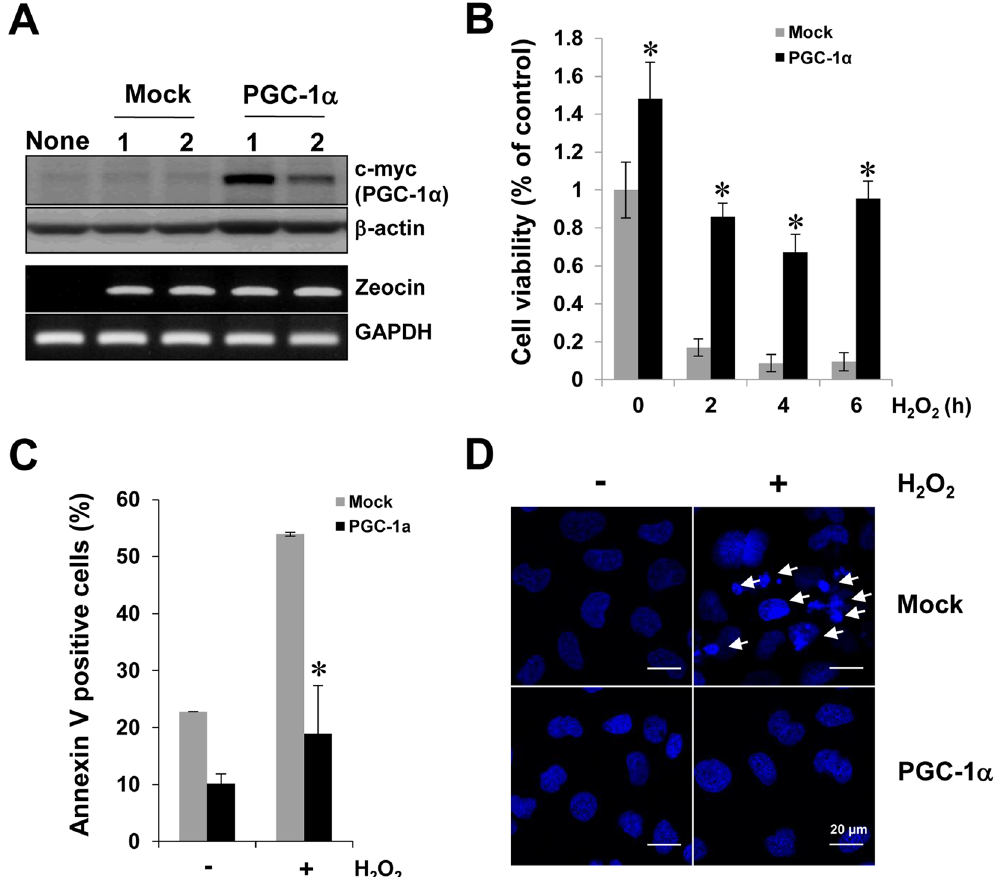
Figure 3. Protective effect of PGC-1 α in H 2 O 2 -mediated cellular injury. To verify the role of PGC-1 α in H 2 O 2 - mediated cellular injury, we developed stable cell lines over-expressing PGC-1 α in HK-2 cells, as mentioned in the Materials and Methods section. ( A ) Expression of PGC-1 α in Mock and PGC-1 α stable cells. The protein expression (upper panel) of c-terminal c-Myc tagged PGC-1 α was assessed with anti-c-Myc and stable cells were selected via the confirmation of zeocine expression (upper panel), which was contained in the backbone plasmid, pCDNA4 . Full-length blots of each tested protein are reported in Supplementary Figure S3. ( B ) Cell viability of Mock and PGC-1 α -stable cells. Stable cells were treated with 0.5 mM H 2 O 2 for an indicated time (0, 2, 4, and 6 h). Cell viability was evaluated by the MTT method. ( C ) Quantification of apoptotic cells. Mock and PGC-1 α cells were treated with 0.5 mM H 2 O 2 for 4 h. Apoptotic cell numbers were measured by counting Annexin V positive cells using a FACSCalibur TM flow cytometry. ( D ) Apoptotic body formation in H 2 O 2 -treated Mock and PGC-1 α stable cells. Apoptotic body formation (arrows), as an indicator of apoptosis, was determined by DAPI staining then photographing cells under fluorescence microscopy as described in the Materials and Methods. Image was magnified at x800, Bar = 20 μ m. Error bars denote the mean ± S.D. of triplicate samples. * p < 0.05 Mock vs. PGC-1 α